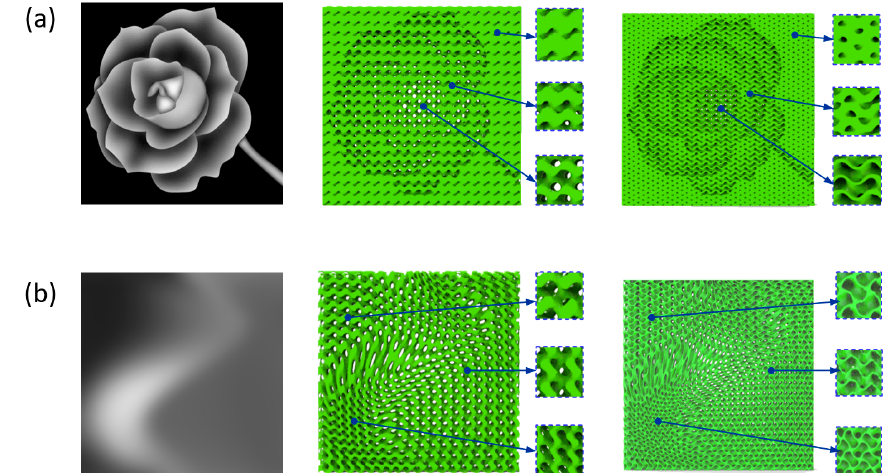
Figure 2. Examples of a Gyroid-based functionally graded scaffold (FGS) using network and sheet structures by ( a ) grading level parameter and ( b ) grading cell size.